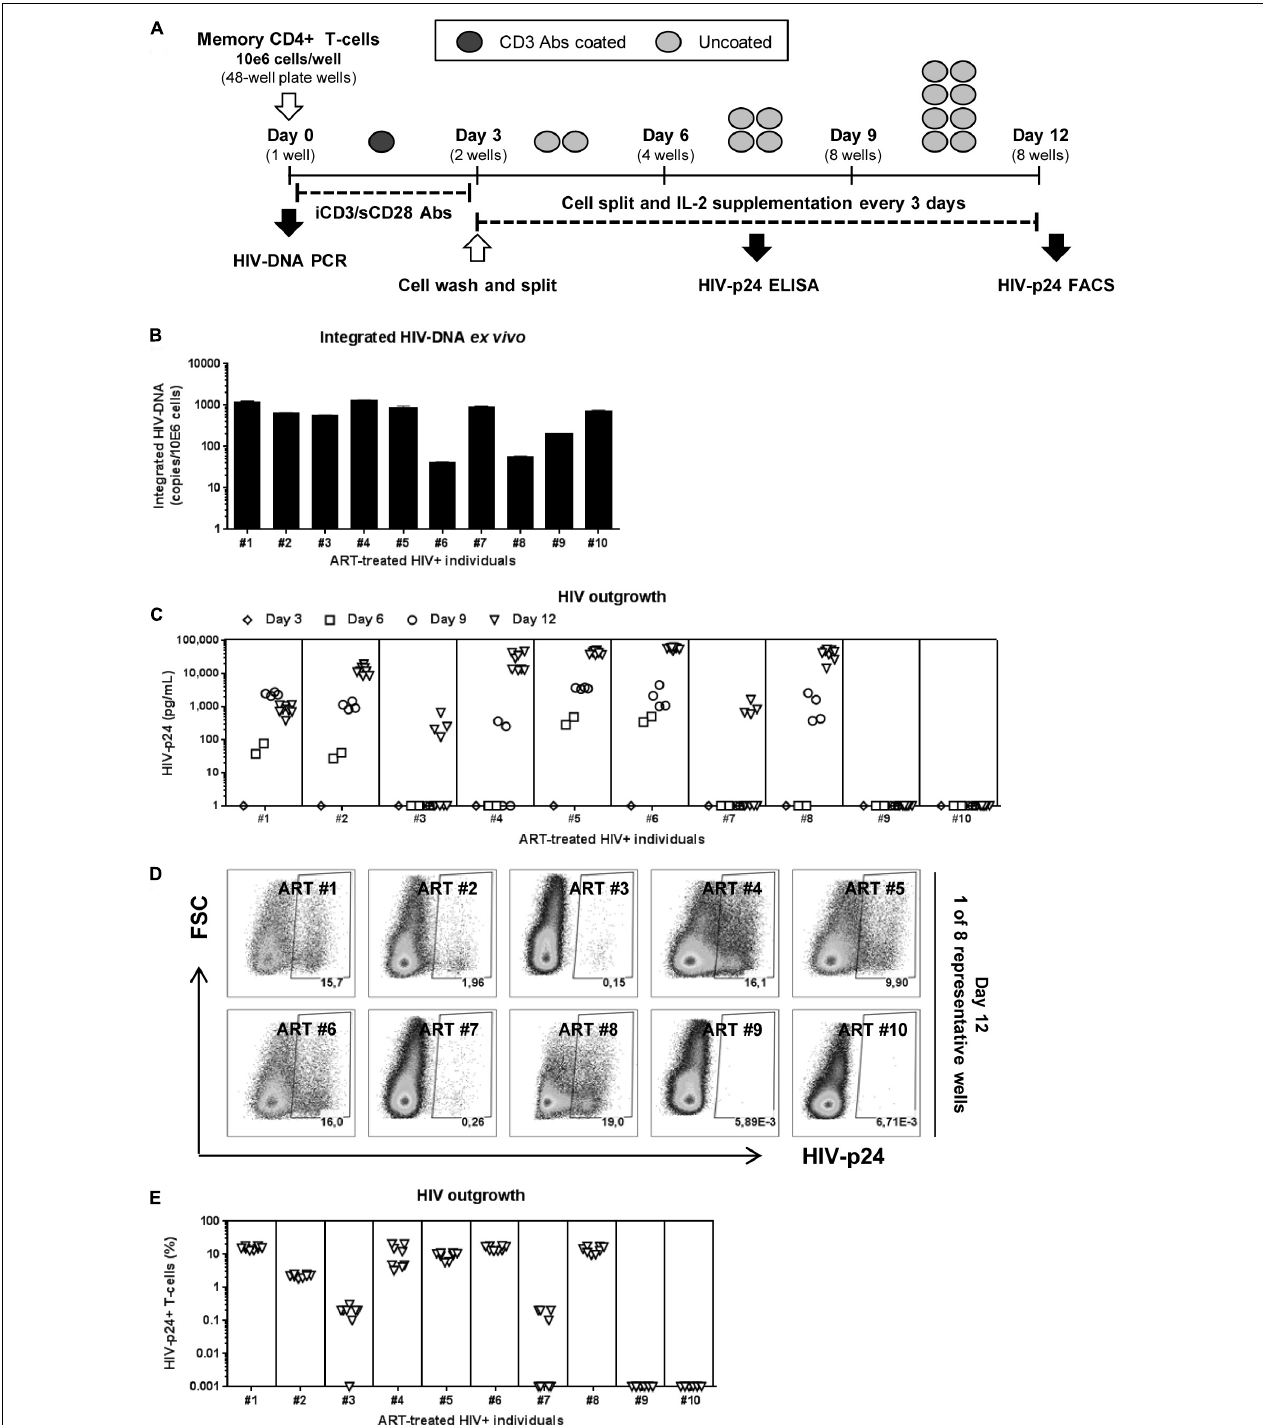
FIGURE 1 | HIV reservoir outgrowth in memory CD4 + T-cells of HIV-infected ART-treated individuals. Memory CD4 + T-cells were isolated by MACS from PBMCs of ART-treated PLWH (HIV+ART) individuals ( Supplementary Table S1 ; HIV+ART #1–10). (A) Shown is the viral outgrowth procedure (VOP) performed as described in the Results and Materials and Methods. (B) Shown are integrated HIV-DNA levels (mean ± SD of triplicate wells) in memory CD4 + T-cells (10 5 cells/PCR reaction) from each donor ex vivo . (C) Shown are HIV-p24 levels measured by ELISA in cell-culture supernatants collected at day 3 (1 well/donor), day 6 (2 wells/donor), day 9 (4 wells/donor), day 12 (8 wells/donor) post-culture. At day 12 post-stimulation, cells were harvested and used for intracellular staining with HIV-p24 Abs and subsequent flow cytometry analysis. Shown are (D) representative flow cytometry dot plot and (E) graphical representation of the percentage of HIV-p24 + T-cells (8 wells/individual) in n = 10 HIV+ART individuals. Each symbol represents one experimental replicate well, with a total of 8 wells/individual at day 12.